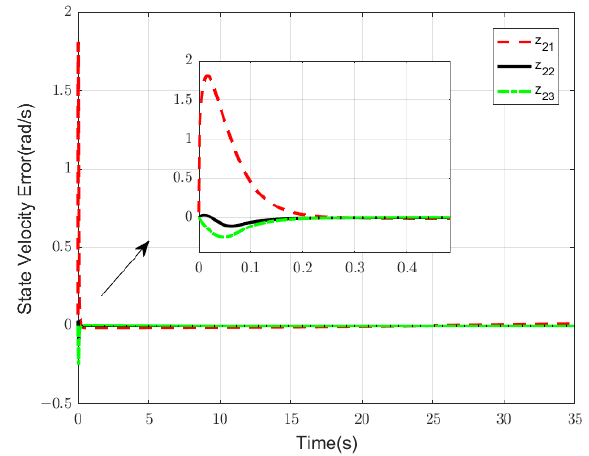
Figure 10. Attitude velocity errors.